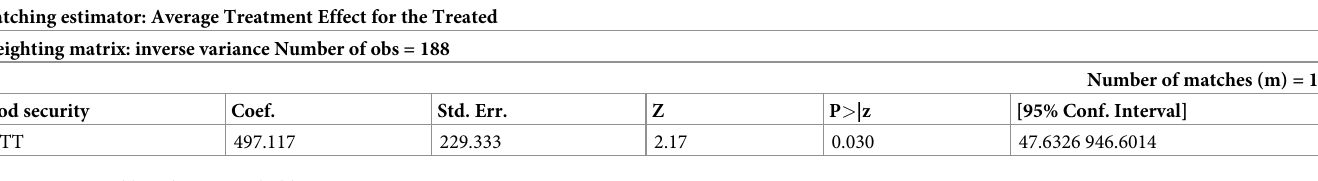
Source: Computed based on Household Survey